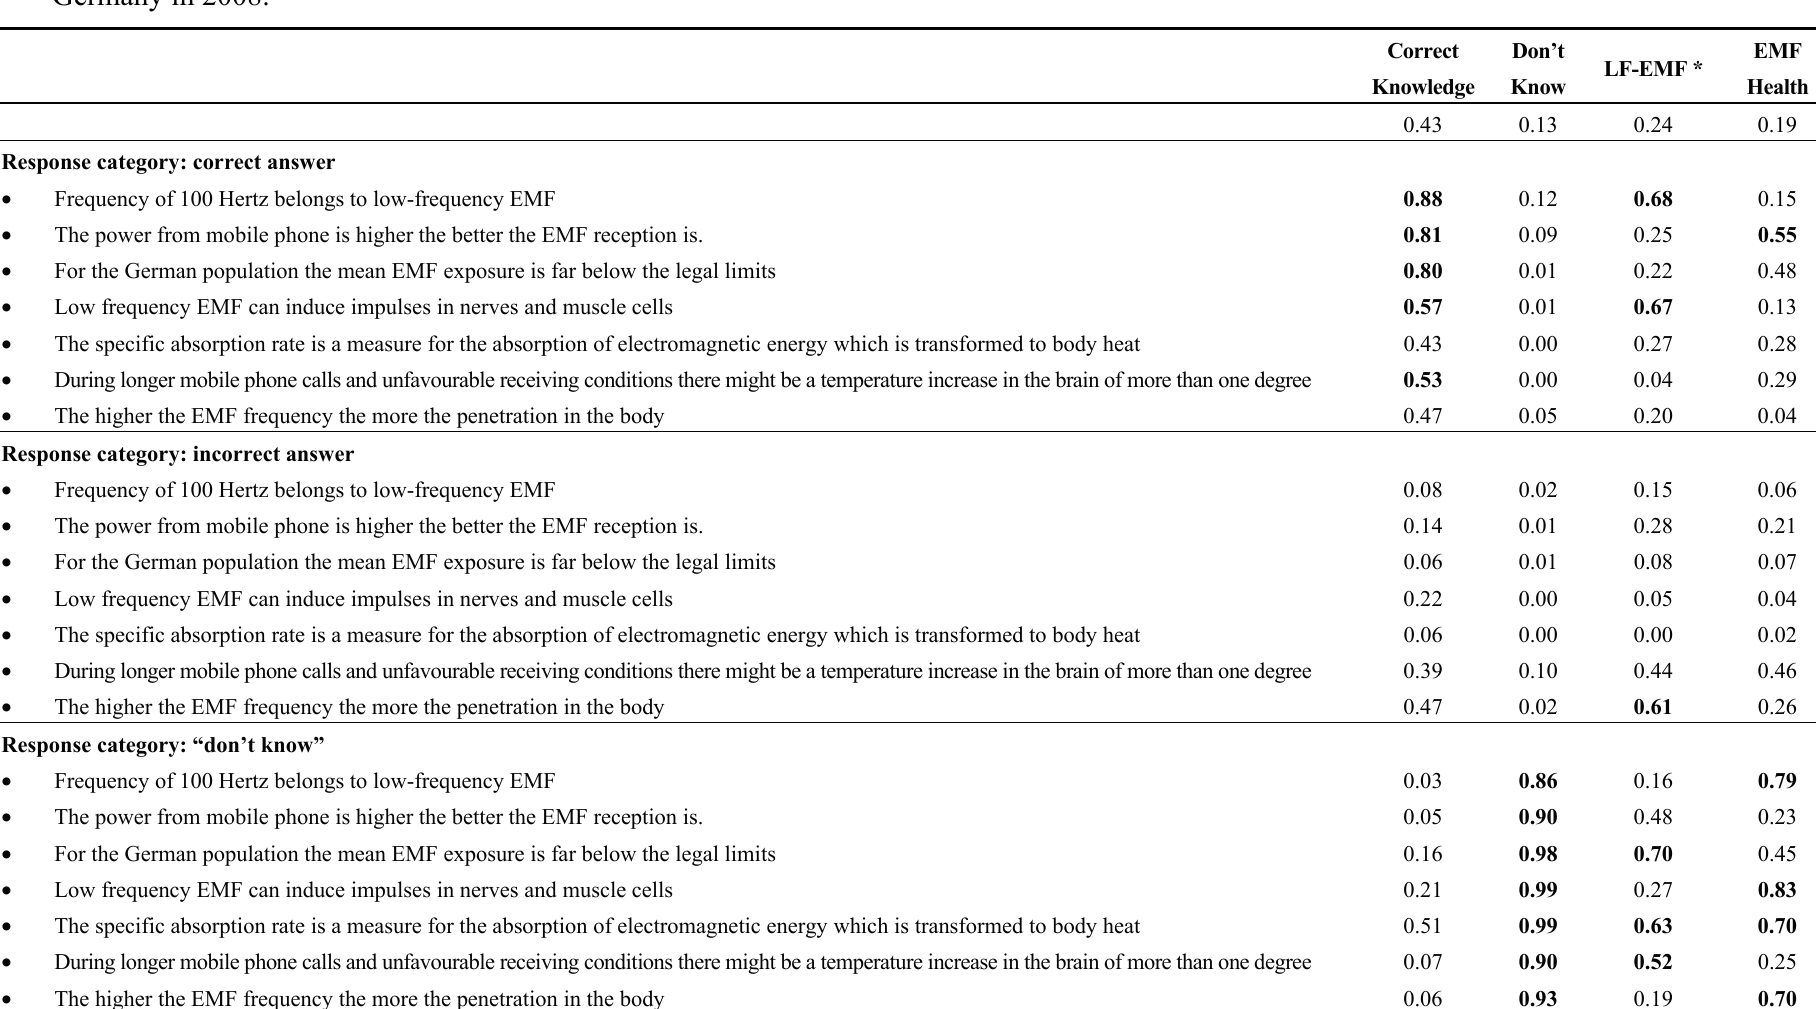
Table 3. Results of the latent class analysis, based on probabilities for each response category for the different knowledge questions, GPs in Germany in 2008.